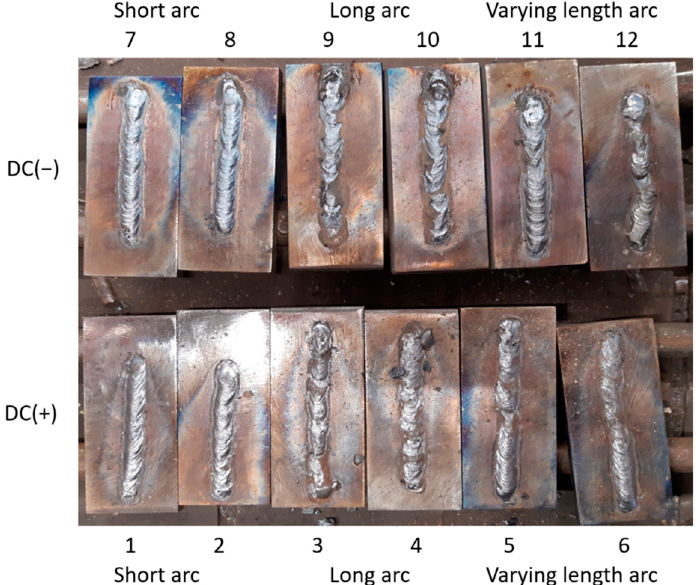
Figure 10. View of test clads made during the experiment with the constant welding current 140 A.